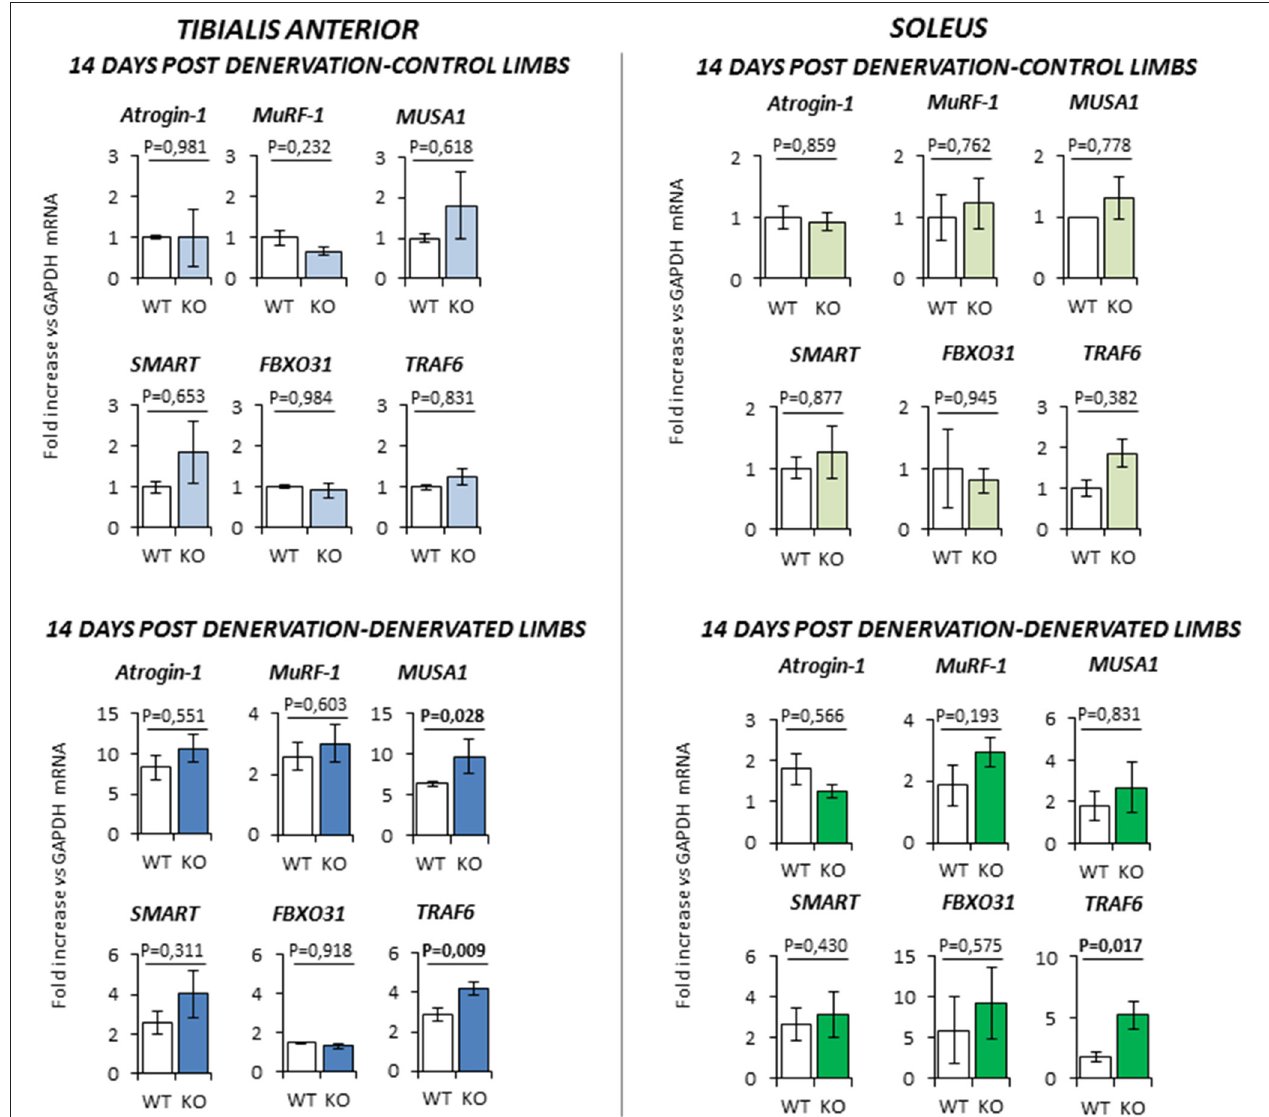
FIGURE 6 | Gene expression analysis in both contralateral control limbs and denervated limbs in wild type (WT, N = 6) and Rxfp2 − / − mice (KO, N = 5), 14 days after denervation. Data in tibialis anterior and soleus muscle specimens are reported for Atrogin-1 , MuRF-1 , MUSA1 , SMART , FBOX31, and TRAF6 genes, whose expression is normalized on GAPDH as housekeeping. Data are reported as mean values ± standard error of the mean. Significance: P -values between compared conditions are reported. Significant differences ( P < 0.05) are highlighted in